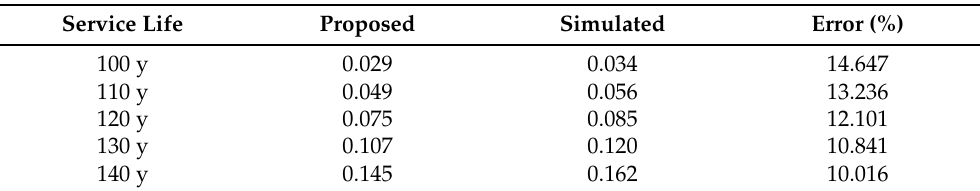
Table 4. The failure probabilities of the surface obtained by the proposed and simulation-based methods ( µ ( x 0 ) = 90 mm).